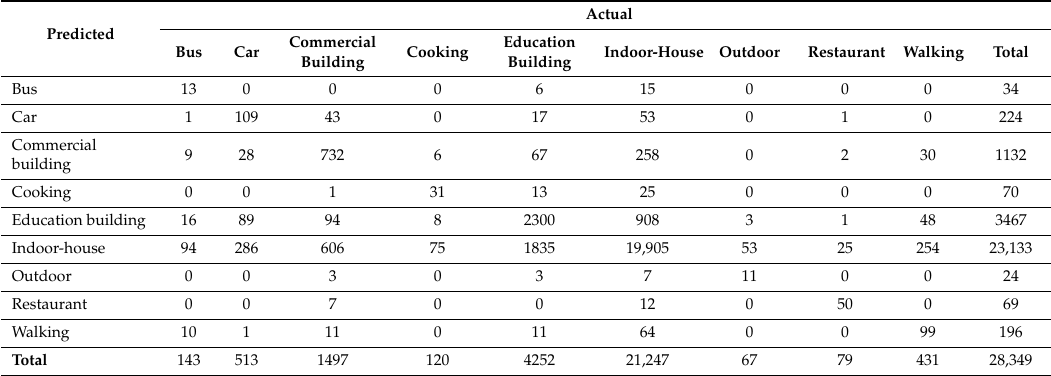
Table 3. Confusion table for test data simulation using raw